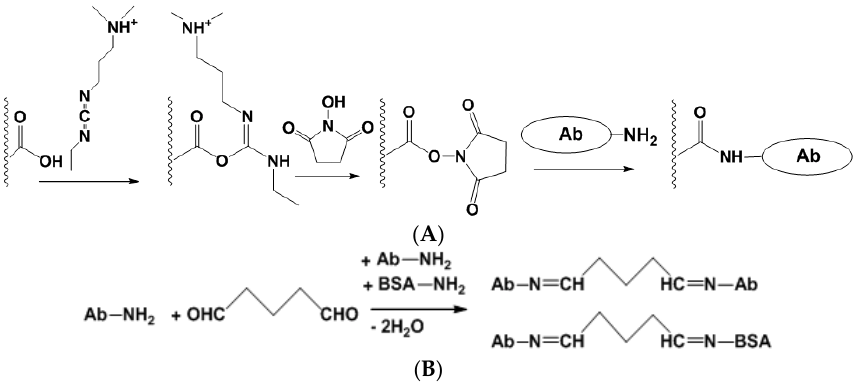
Figure 5. Carbodiimide binding ( A ) and cross-linking with glutaraldehyde ( B ) for the covalent immobilization of Ab.